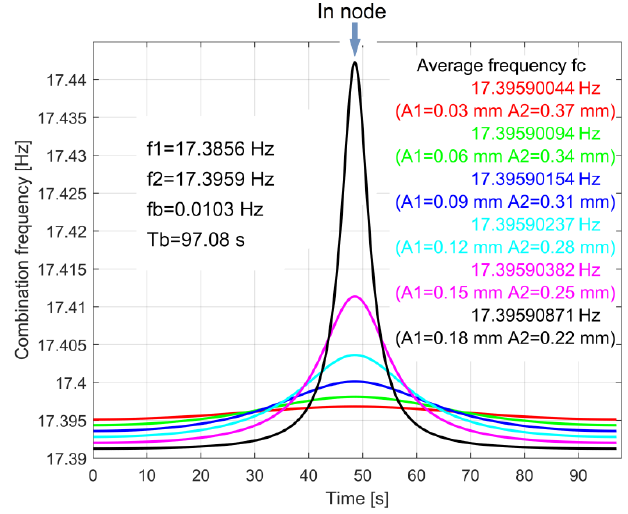
Figure 9. The evolution of the instantaneous combination frequency f c on the simulated vibration beating during a beat period T b (with A 2 > A 1 and f 2 > f 1 ).